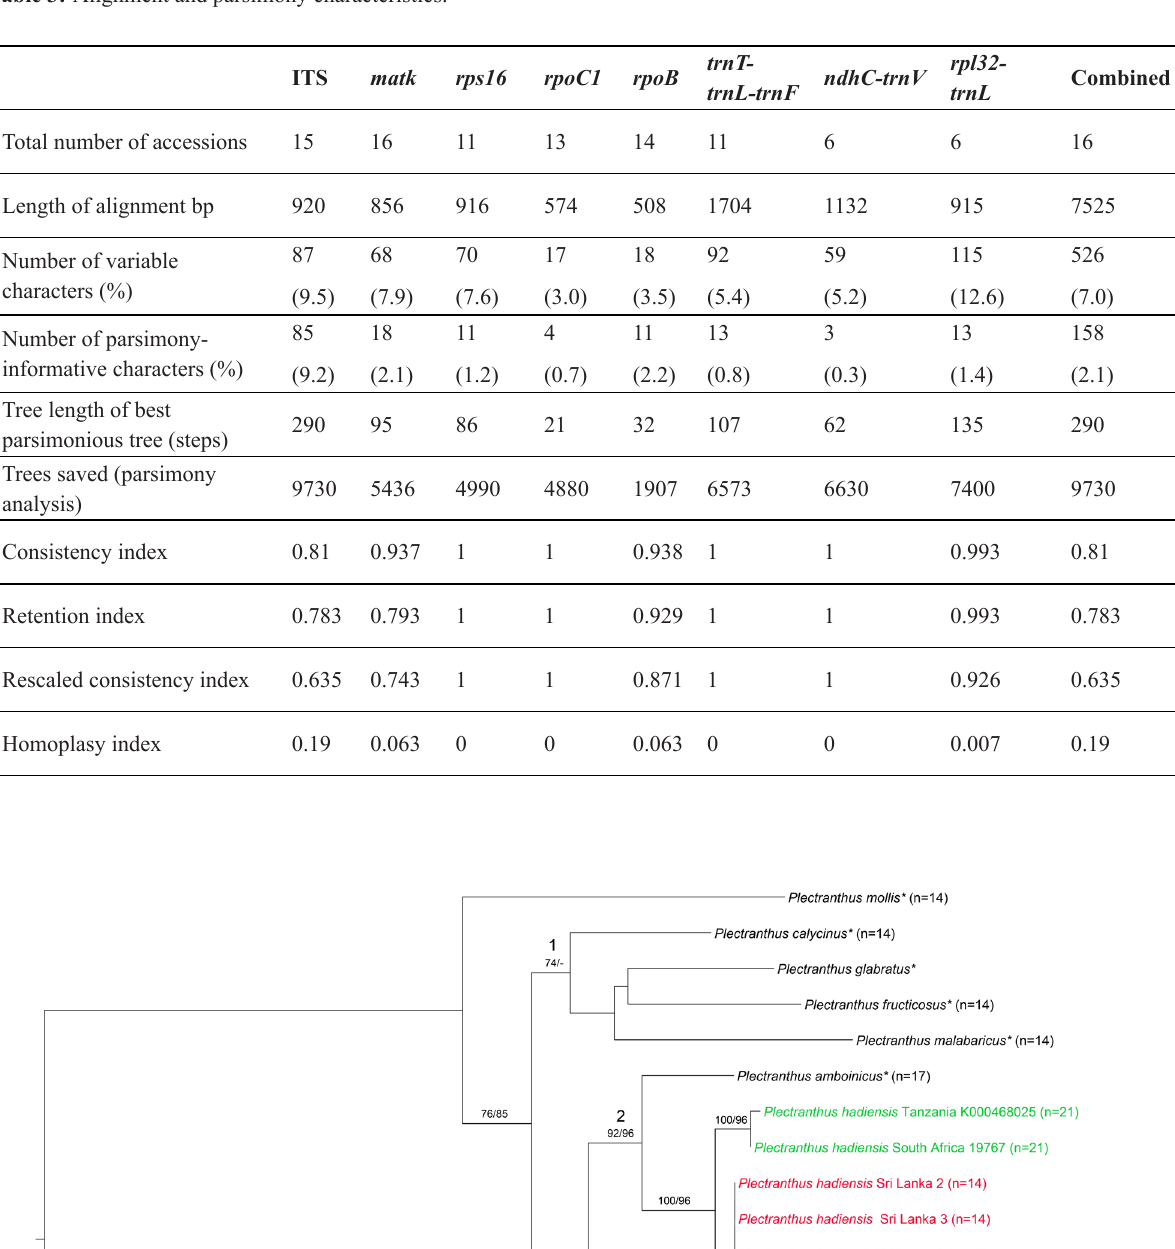
Table 3: Alignment and parsimony characteristics.